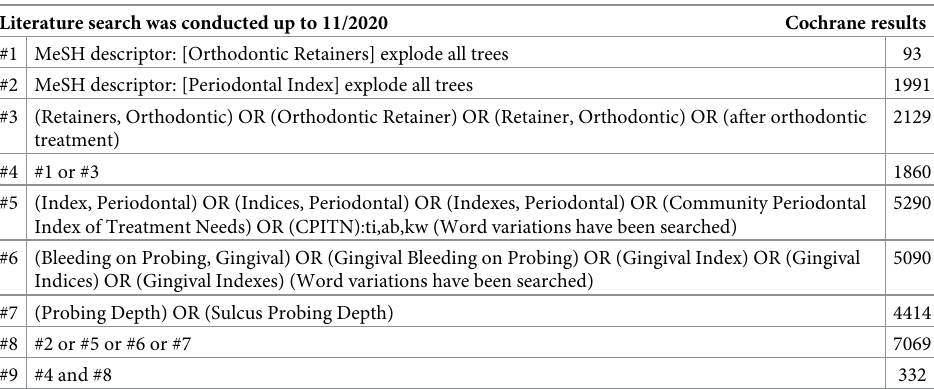
Table 2. Search strategy for Cochrane Library